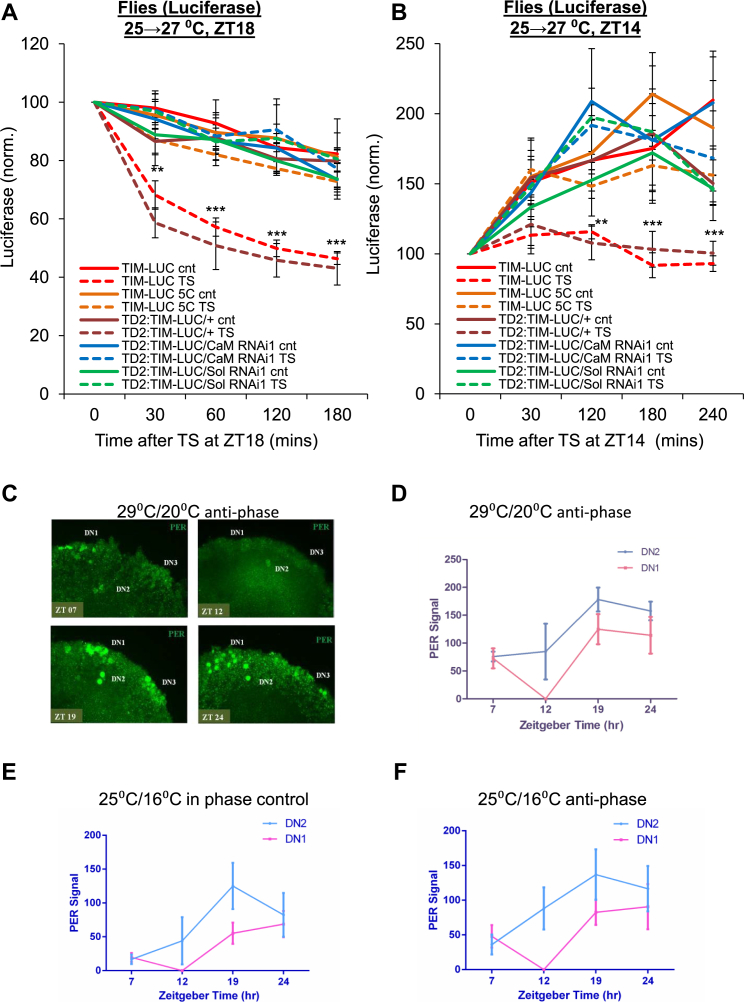
TIM Responds to Small Temperature Increases, and Isolated Brains Are Sensitive to Temperature Cycles, Related to Figure 5(A and B) 25°C to 27°C TS causes rapid degradation of TIM both at ZT18 (A) and ZT14 (B). This degradation is blocked by CaM or SOL RNAi and TIM-LUC 5C mutation.(C and D) Dissected Drosophila brains entrain to temperature cycles. Flies were entrained to a 12/12 light/dark cycles and their brain was dissected during the light phase. They were then exposed to in-phase (control) or 12 hr shifted (anti-phase) temperature cycles as indicated. Brains were then harvested at different Zeitgeber Times (ZT) and stained with anti-PER antibody (the ZTs on the X-axes are relative to the temperature cycle). Representative images for anti-PER staining of DN1-3 clock neurons in brains that were shifted to a 12 hr anti-phase 29°C/20°C TC are shown in (C) with quantification of immunostainings showing that both DN1 and 2 were entrained to the anti-phase TC (D).(E and F) Similar results were observed when a 25°C/16°C TC was used. Note that the in-phase control (C) and 12 hr anti-phase (D) brains have identical phase with respect to the temperature cycle, which proves entrainment. Staining in Lateral Neurons was weak and could not be reliably quantified. Error bars: SEM. For (A and B), p < 0.01 or p < 0.001 from at least three independent experiments (n ≥ 6 each) is indicated with “∗∗” or “∗∗∗,” respectively.